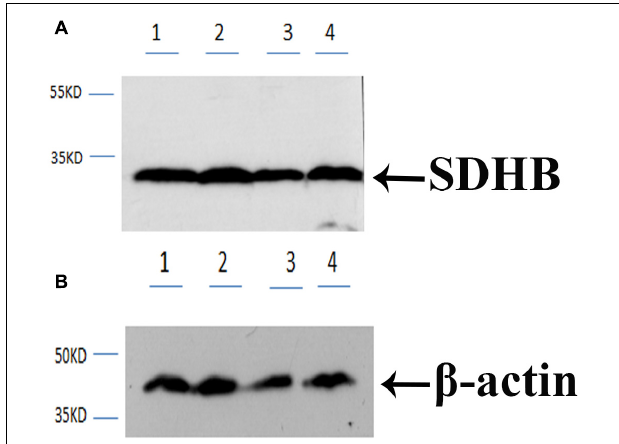
FIGURE 6 | Expression characterization of Mn-SDHB in different reproductive cycles ovary. The amount of Mn-SDHB mRNA was normalized to the EIF transcript level. Data are shown as mean + SD (standard deviation) of tissues from three separate individuals. Capital letters indicate expression difference between different